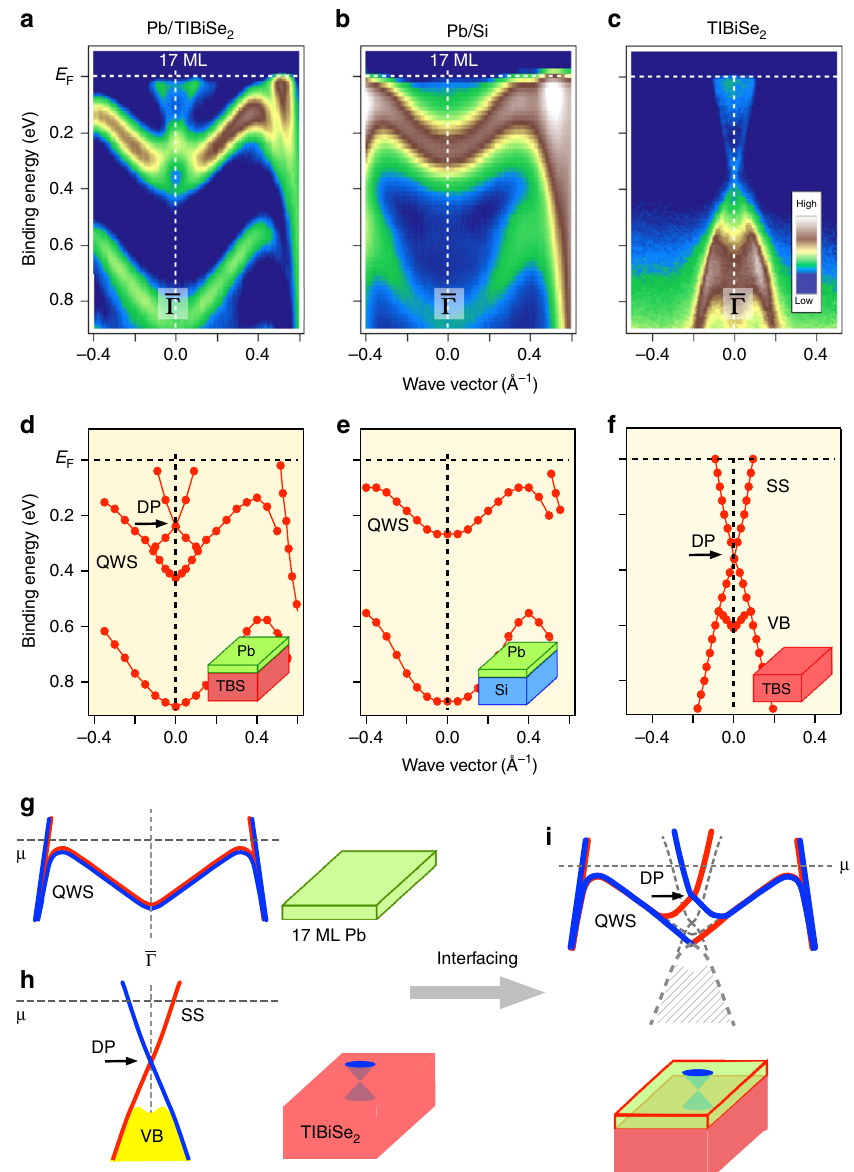
Fig. 2 Migration of topological surface states to the surface of Pb fi lm. a – c ARPES-derived band structure near E F around the Γ point for 17ML-Pb/ TlBiSe 2 , 17ML-Pb/Si(111), and pristine TlBiSe 2 , respectively, with the He-I α line. The data were obtained along the Γ K cut parallel to the analyzer slit, so that the energy and momentum resolutions are better than the data in Fig. 1d, f, h measured along the Γ M cut perpendicular to the analyzer slit. d – f Experimental band dispersions extracted from the peak positions of MDCs/EDCs for a – c . g – i Schematics of the hybridization between topological Dirac- cone state and QWSs, showing the migration of topological Dirac-cone state upon interfacing Pb with TlBiSe 2 . Dashed curves in i indicate the band dispersion without hybridization. Note that the bulk VB of TlBiSe 2 indicated by gray shade becomes invisible on the Pb/TlBiSe 2 interface, because only the topological SS migrates to the top